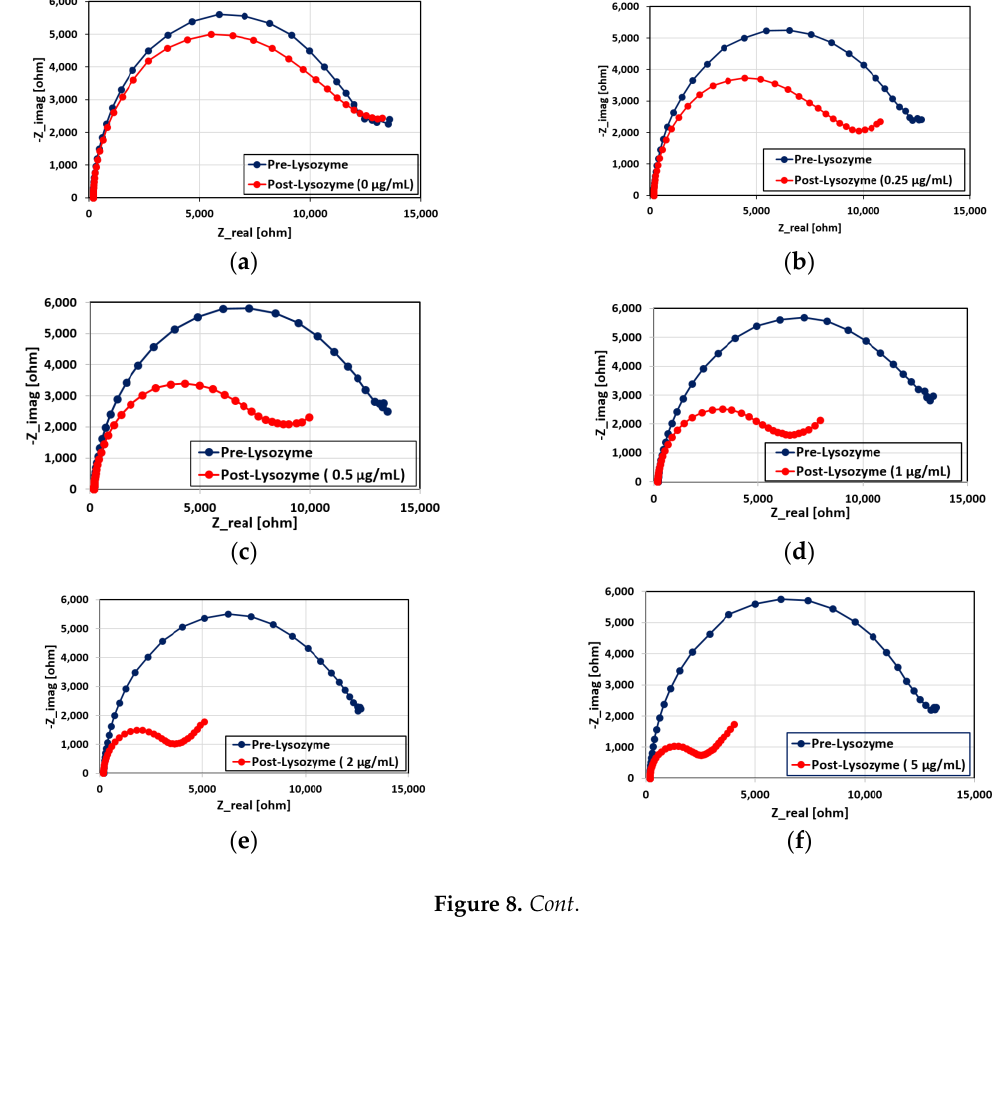
( i ) Figure 8. ( a )–( h ) Pre- and post-lysozyme Nyquist curves for different concentrations of lysozyme (0, 0.25, 0.5, 1, 2, 5, 10, 20 µg/mL, respectively) in 50 mM PBS as well as ( i ) post-lysozyme Nyquist curves for all the lysozyme concentrations.